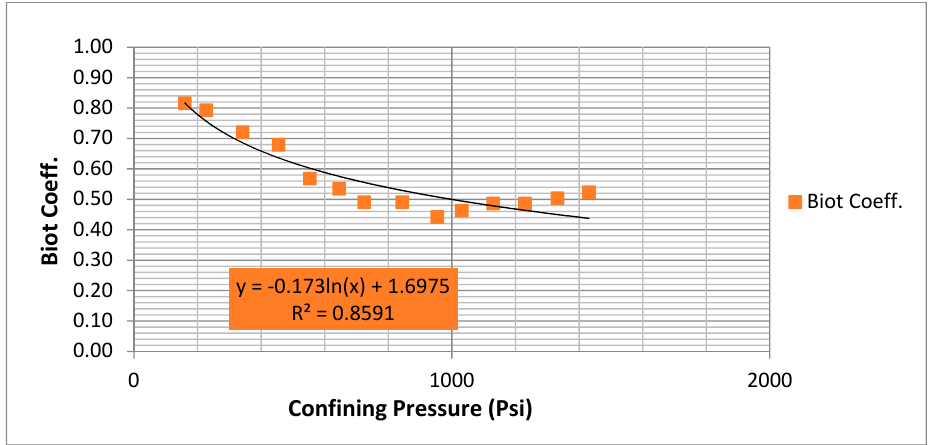
Figure 19. Biot coefficient vs. confining pressure for H6.